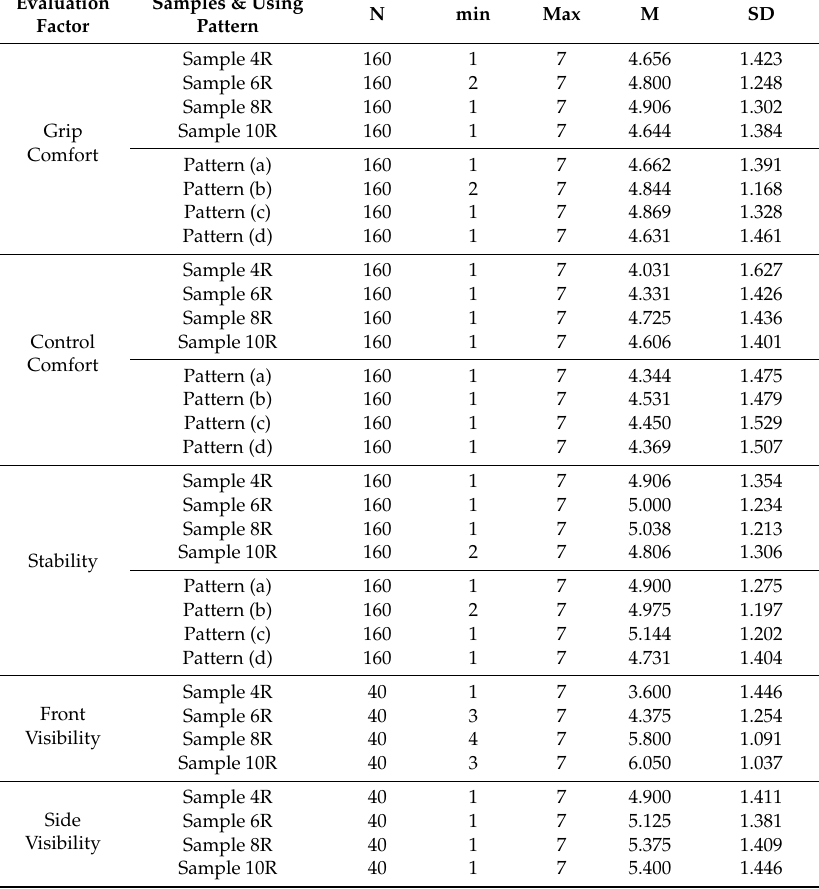
Table 3. Results of descriptive statistics for the